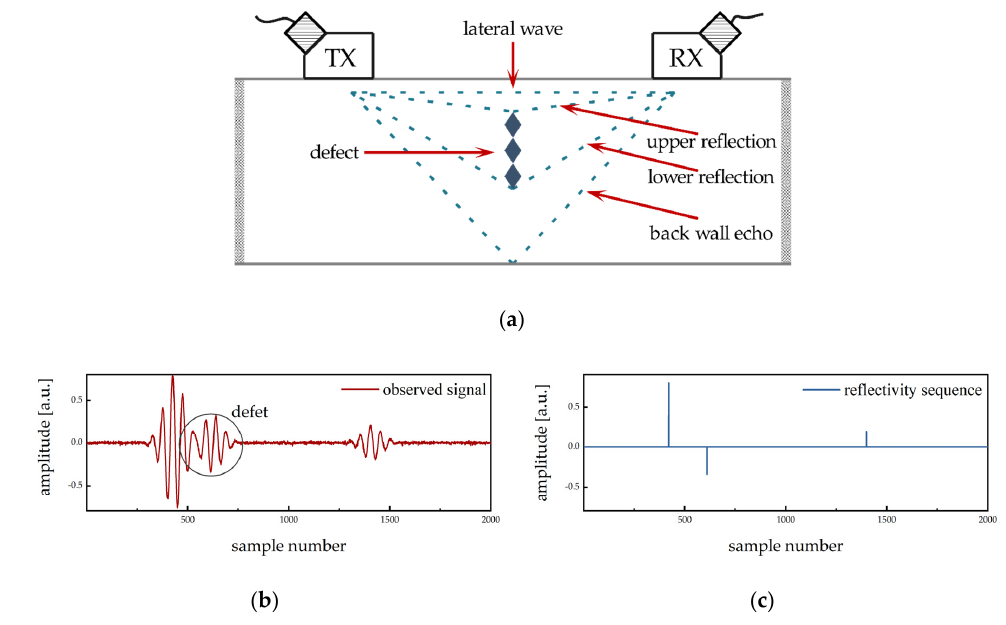
Figure 1. Diagram for time of flight diffraction (TOFD) testing and example of A-scan signal: ( a ) TOFD arrangement for defect inspection; ( b ) observed receive signal sample by convolution; ( c ) hypothetical reflectivity sequence.